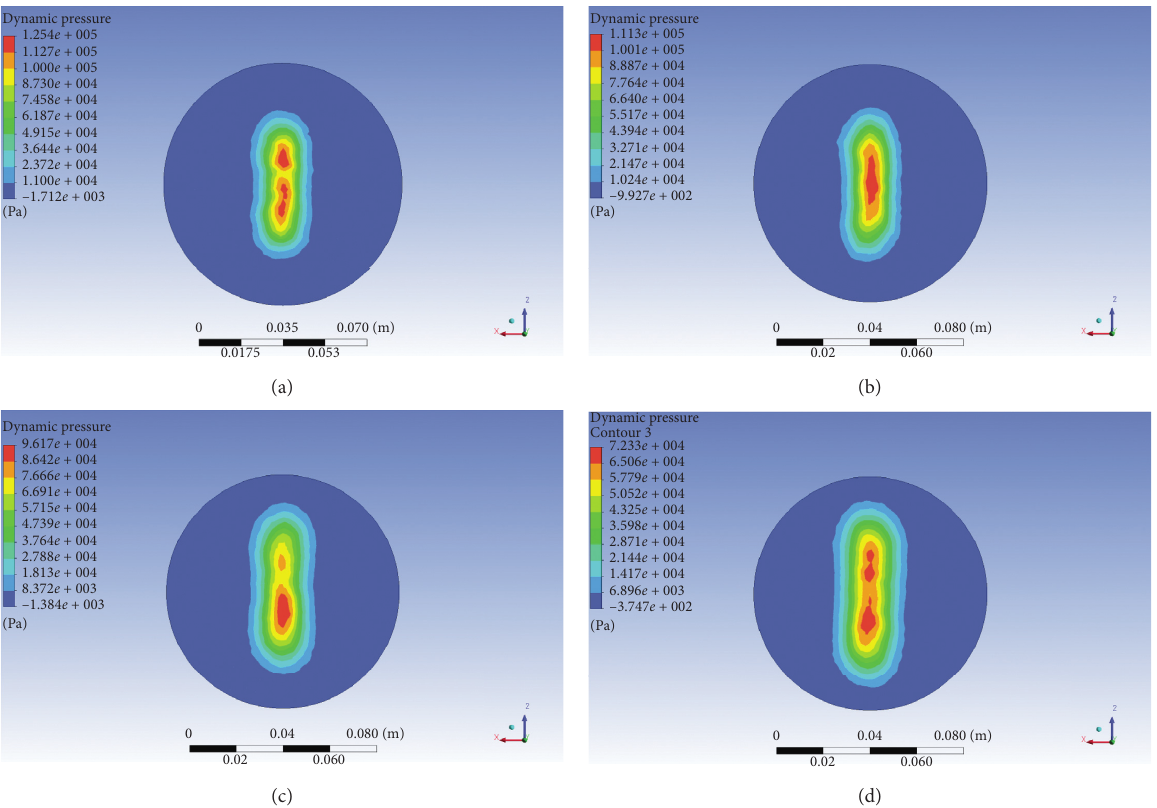
Figure 6: Dynamic pressure nephogram of target surface at different target distances. (a) 60mm. (b) 70mm. (c) 80mm. (d) 100mm.